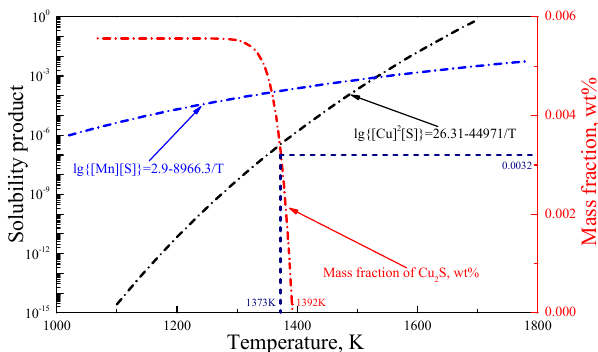
Figure 7. Equilibrium solubility product of MnS and Cu 2 S and the precipitation curve of Cu 2 S.